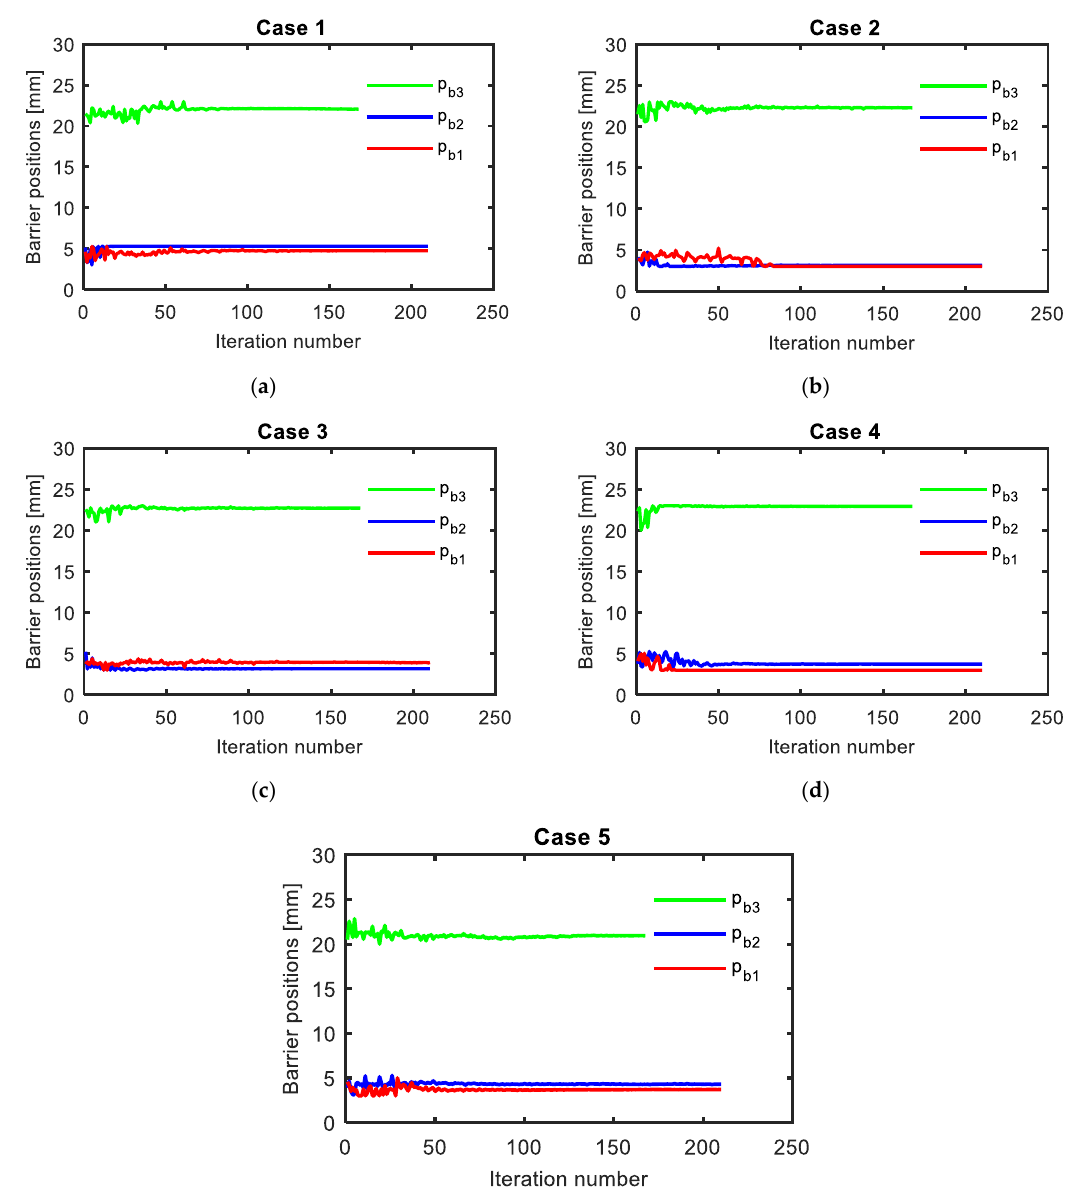
Figure 10. Optimal geometry of flux barrier positions for different cases, ( a ) case 1, ( b ) case 2, ( c ) case 3, ( d ) case 4 and case 5. ( e ) case